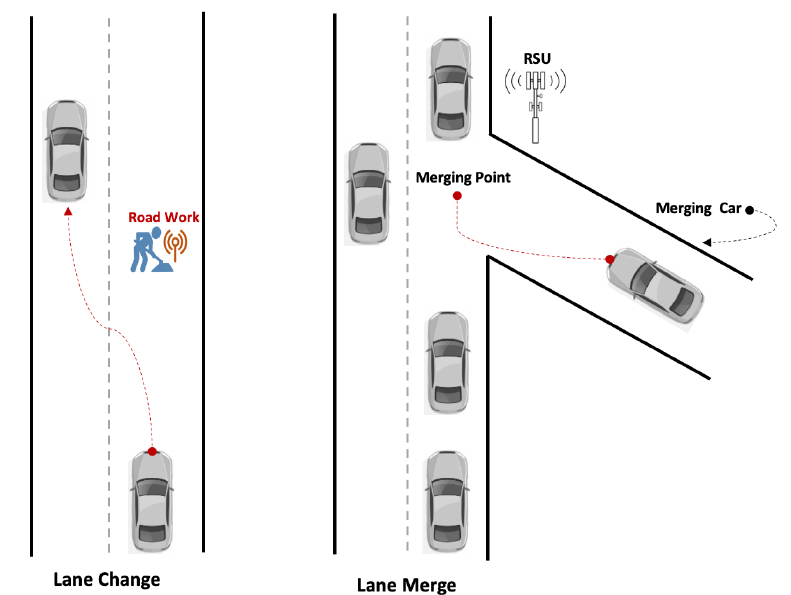
Figure 4. Illustration of lane change and